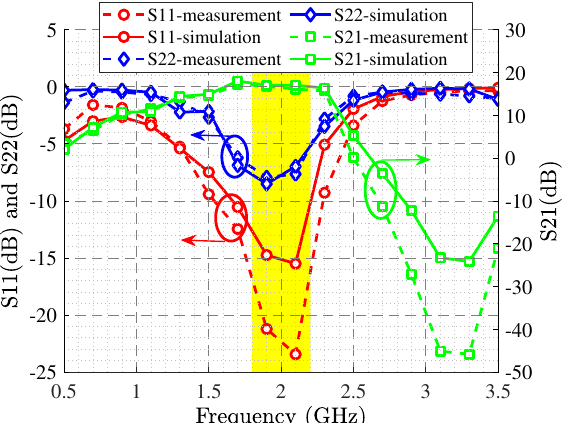
Figure 6. Simulated and measured S-parameters of the optimized